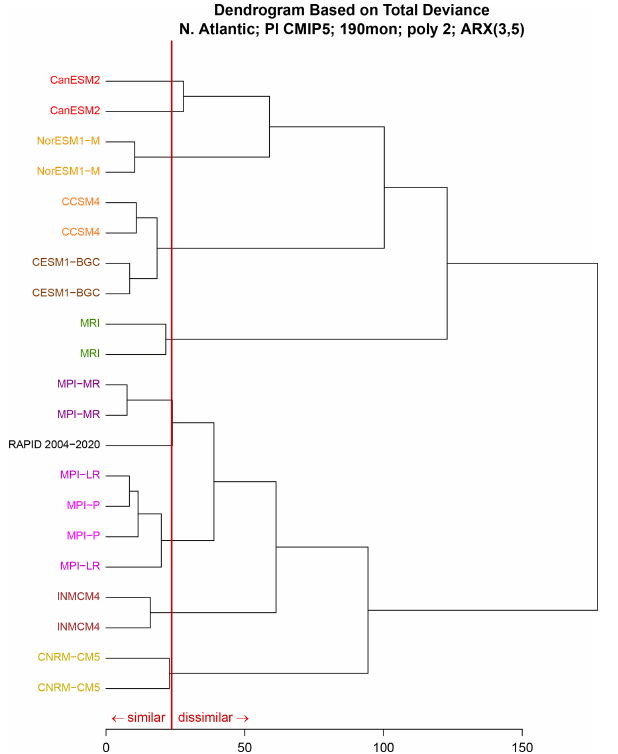
Figure 8. A dendogram showing clusters based on total deviance D (cid:127) . All time series are of length 190 months. Two independent 0 : 3 time series from the same CMIP5 model are included in the cluster analysis. The vertical red line shows the 5% significance level for the deviance. Leaves joined to the left of the significance line are statistically indistinguishable from each